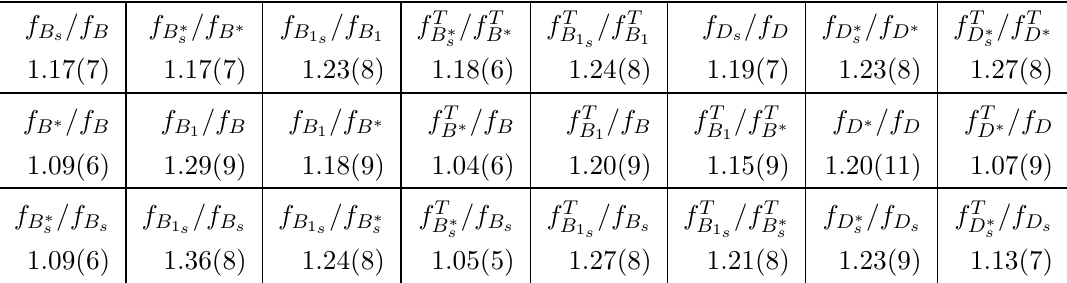
Table 10 . Ratios of various decay constants in the kinetic(MS) scheme for the B ( D ) -mesons. Comparison with the literature can be found in section 4.2.1. Ratios in the MS scheme for the B -mesons are given in table